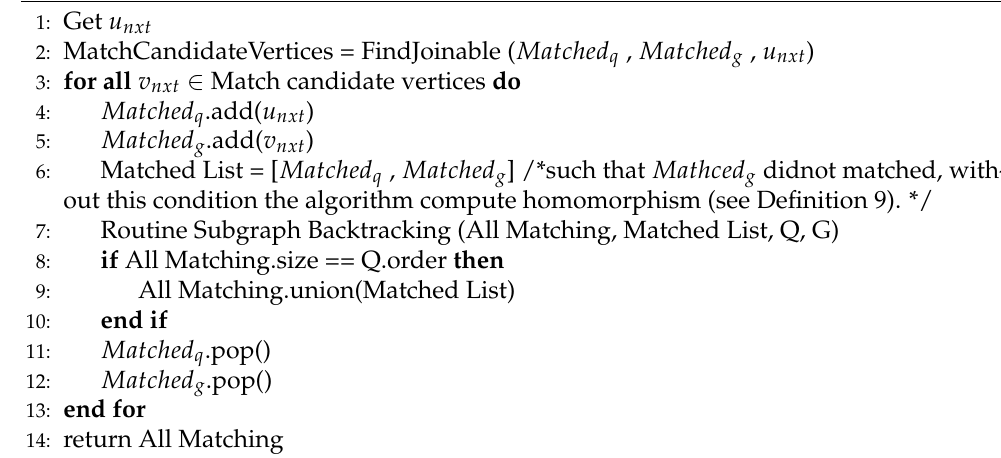
Algorithm 3 : Routine Subgraph Backtracking